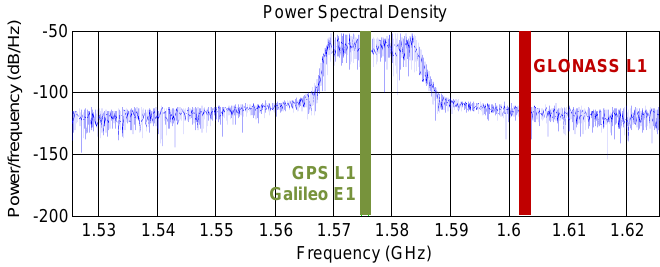
Figure 3. Power spectral density of the used PPD jammer.